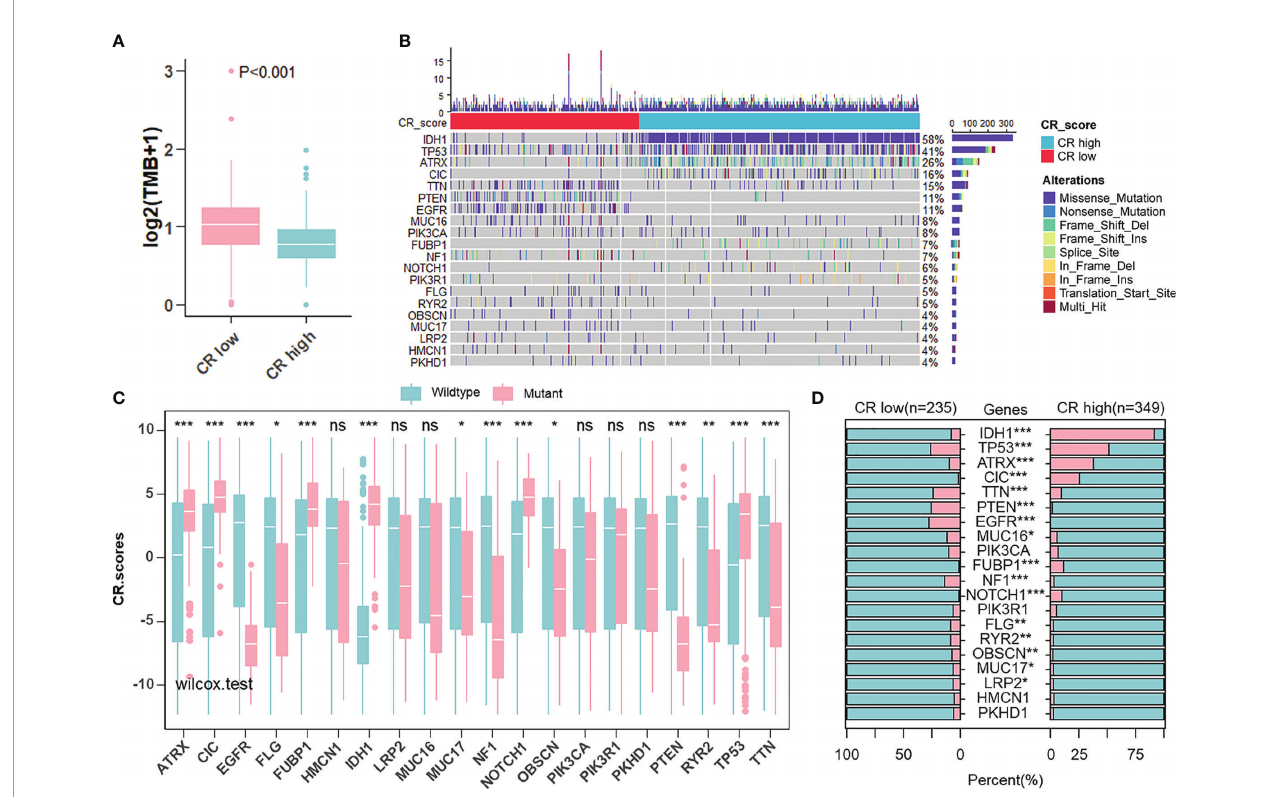
FIGURE 7 | Landscape of tumor somatic mutation in two CR groups. (A) Differences of TMB in CR-high and -low groups in TCGA cohort (Wilcoxon test: p < 0.001). (B) Top 20 most frequent mutations in patients from TCGA cohort and the distribution of mutations in CR high and low groups. (C) Differences in CR scores between wild-type and mutant groups of each of the top 20 genes in the TCGA cohort (Wilcoxon test: ns, P>0.05; * p < 0.05; ** p < 0.01; *** p < 0.001). (D) Differences in the frequency of top 20 mutations between CR-high and -low groups in the TCGA cohort (Fisher ’ exact test: p > 0.05; * p < 0.05; ** p < 0.01; *** p <